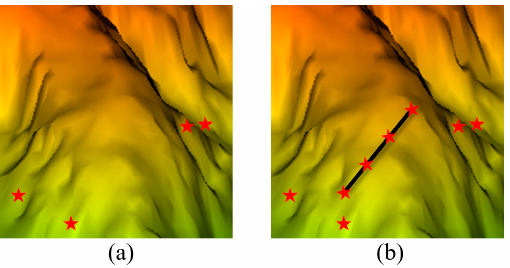
Figure 1. Conceptual diagrams of ground seed identification by using different windows: ( a ) square window; ( b ) narrow rectangle window in east–west direction; ( c ) narrow rectangle window in north–south direction; ( d ) multi-directional narrow rectangle window. Parallelogram boxes represent windows, and red pentagrams are ground seeds that are identified by selecting the lowest points within the windows.